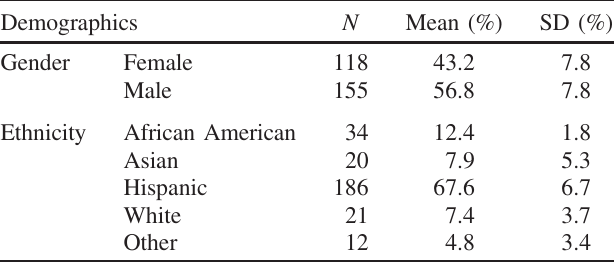
TABLE II. Students ’ gender and ethnicity. For each group, the overall number of students is in the first column, the average percentage of students for all sections is in the second column, and the unbiased estimation of standard deviation between section (SD) is in the third